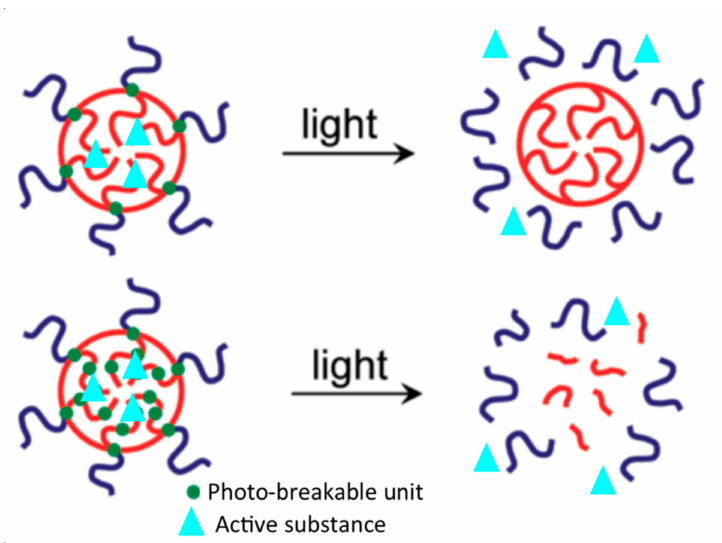
Figure 6. Representative figure of the mechanism of drug release from a light-responsive hydrogel: photoreactive moieties placed at the side group (upper example); photoreactive moieties placed at the main chain (lower example). Source: adapted with permission from [103]. Copyright (2011) American Chemical